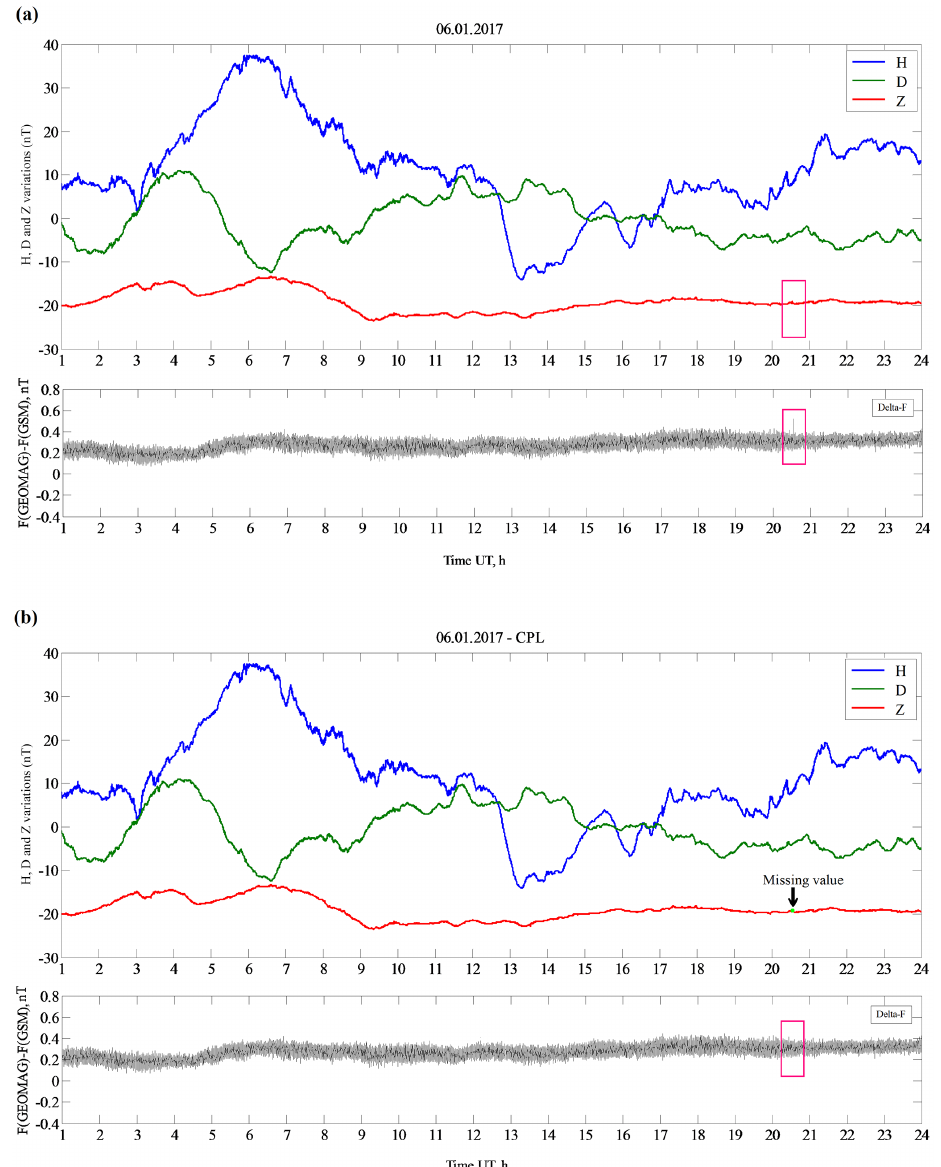
Figure 9. (a) The 1s vector variations and (cid:49)F from GEOMAG-02MO and GSM-90F1 and the observed spike in the Z component and (cid:49)F (highlighted rectangular box) on 6 January 2017; (b) removal of the spike in the Z component (green color dot with highlighted black circle, top panel) and (cid:49)F (highlighted rectangular box, bottom panel) on 6 January 2017 using the Matlab script and replacement of the data with the missing